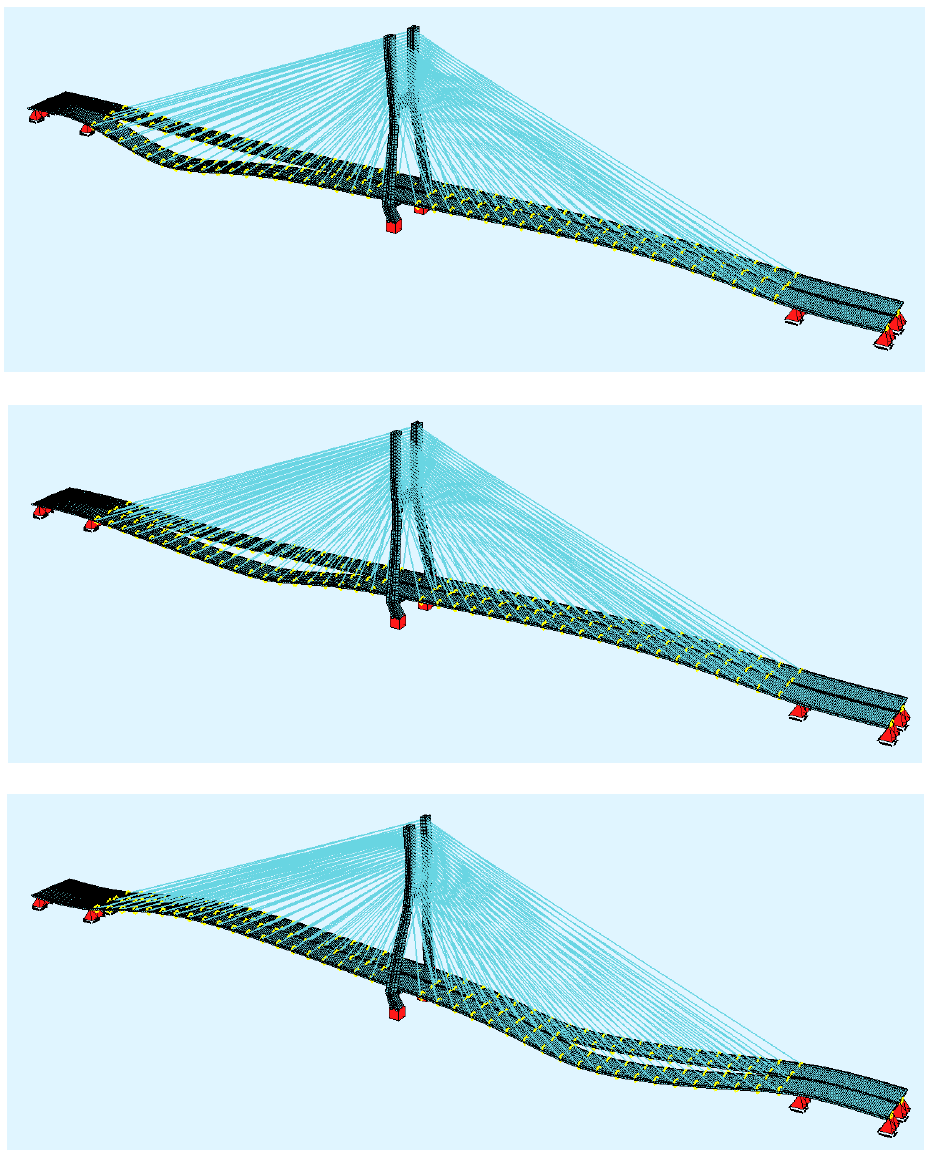
Figure 13. Screenshots from the moving vehicle on the FEM bridge model.